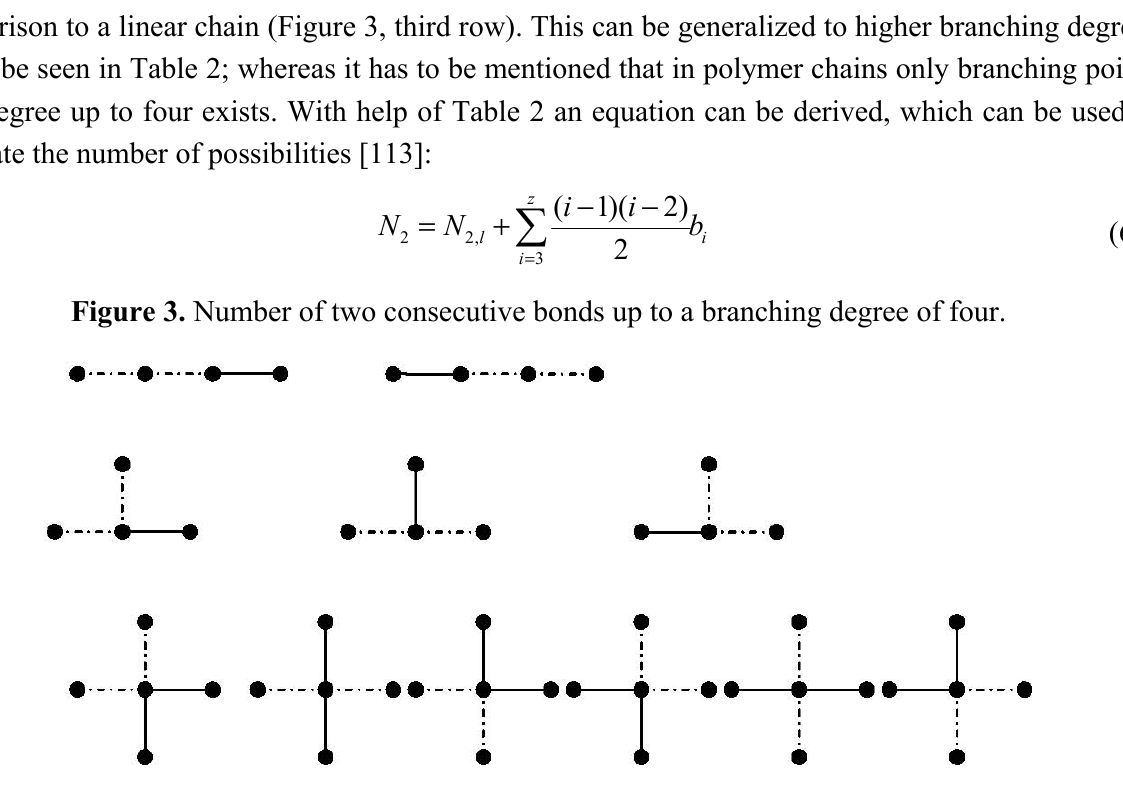
Table 2. Number of additional possibilities of choosing two consecutive bonds on a polymer chain with branching degree up to